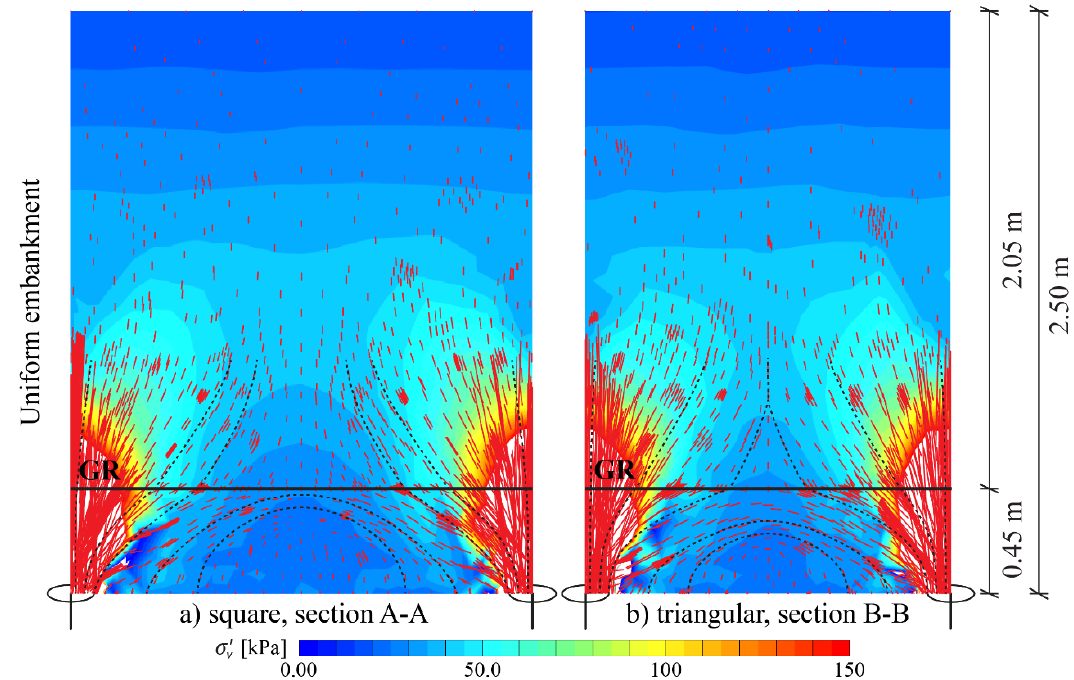
Figure 14. Cross sections (marked in Figure 12) of the modelled embankments with uniform height of 2.50 m and 𝑠 = 1.4 m (marked in Figure 12), showing the distribution of 𝜎 𝘷(cid:4593) and 𝜎 (cid:2869)(cid:4593) -vectors. The 𝜎 (cid:2869)(cid:4593) -vectors, projected on a vertical plane, are marked as red lines and their directions are outlined with dashed lines.